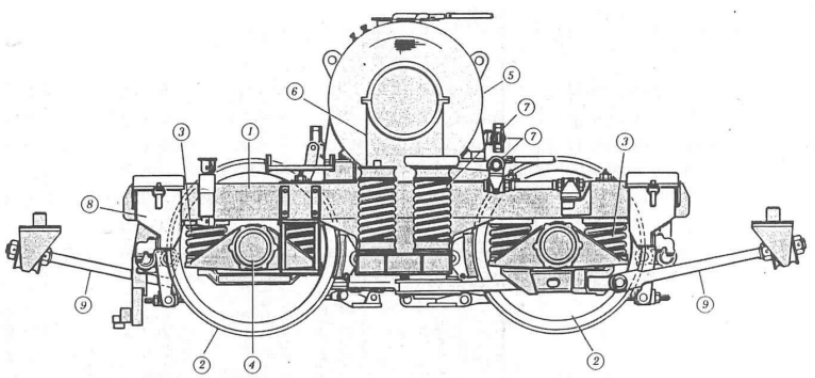
Figure 1. Damping springs of a railway bogie (Díaz [14]).